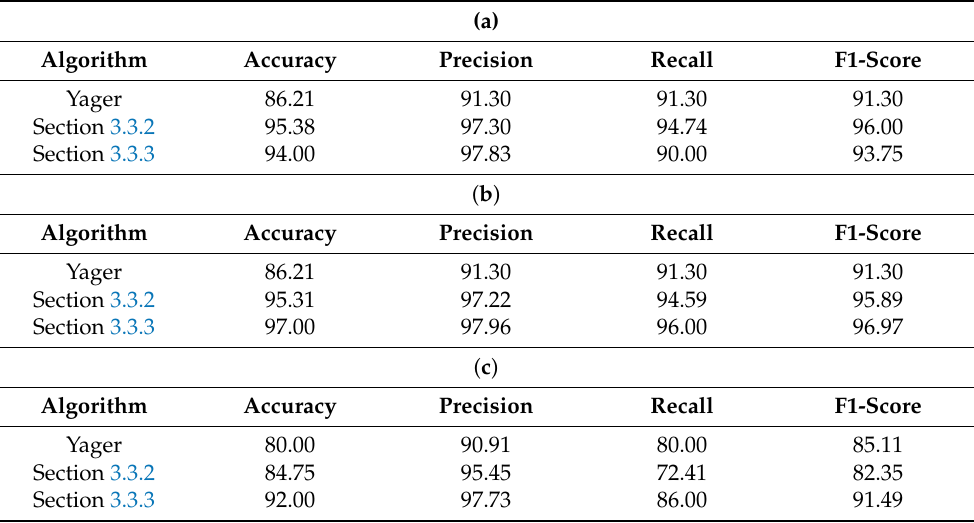
Table 6. Recognition results of different fusion algorithms based on different databases (%). ( a ) Video database combined with Chinese emotional private database; ( b ) video database combined with Finnish emotional private database; ( c ) video database combined with Institute of Automation of Chinese Academy of Sciences (CASIA) public